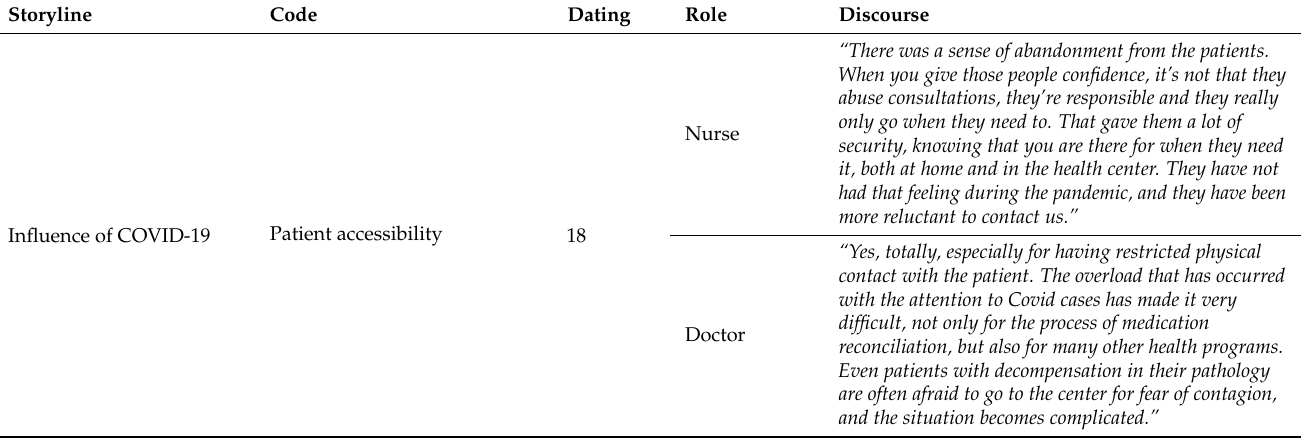
Table 3. Description of the influence of COVID-19. Codes and discourses of the nurses and primary care